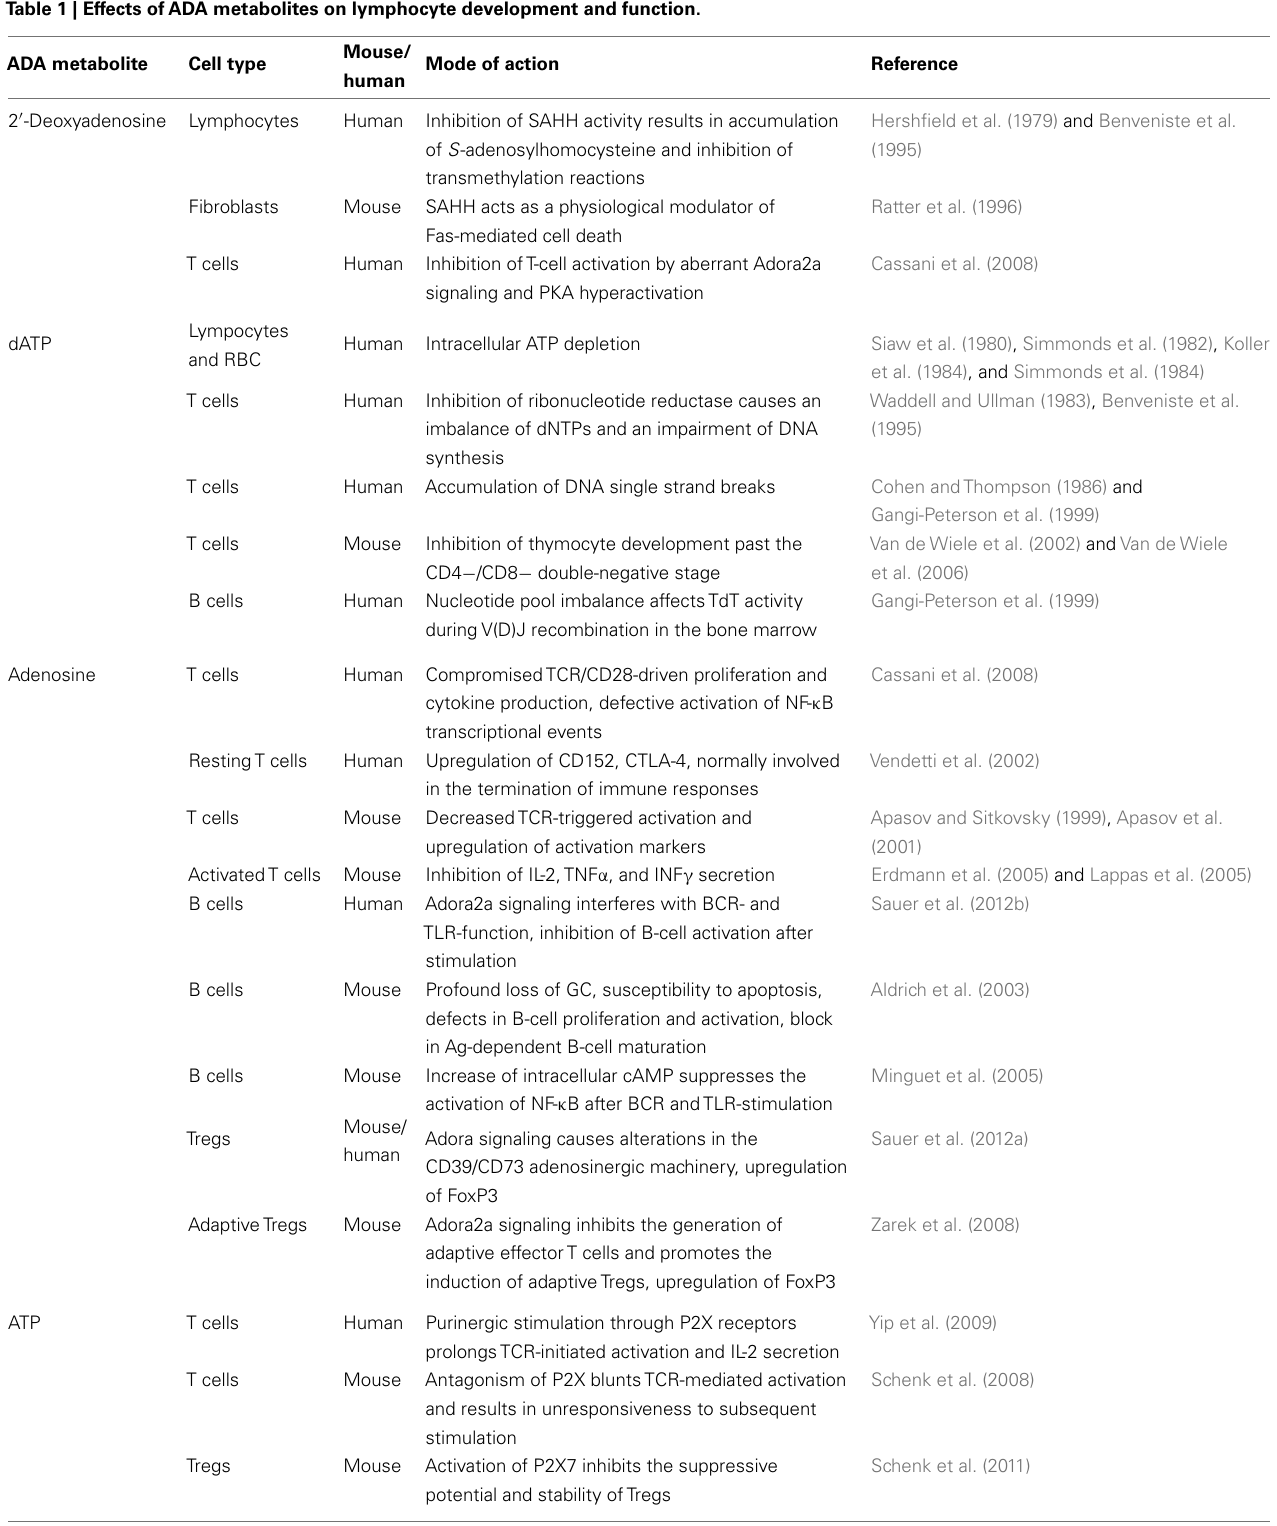
Table 1 | Effects ofADA metabolites on lymphocyte development and